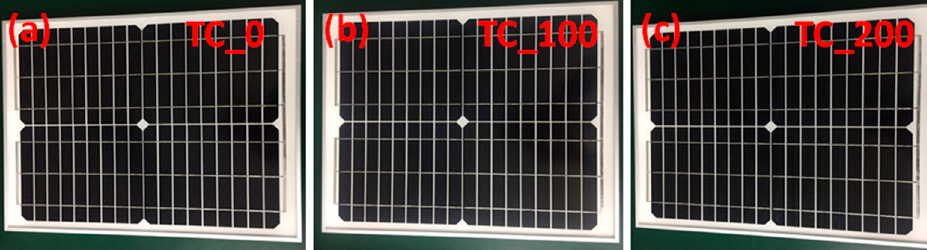
Figure 3. Optical images of the PV module with a concrete slab after thermal cycles of ( a ) 0, ( b ) 100, and ( c ) 200 cycles).